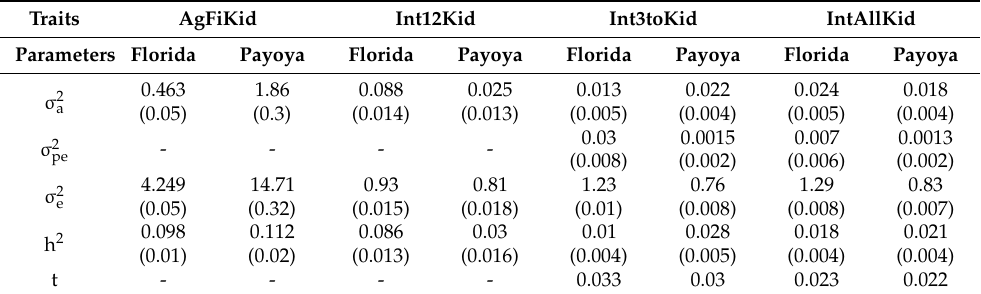
Table 3. Estimates of genetic parameters of fertility traits in Florida and Payoya breeds 1 . Traits AgFiKid Int12Kid Int3toKid